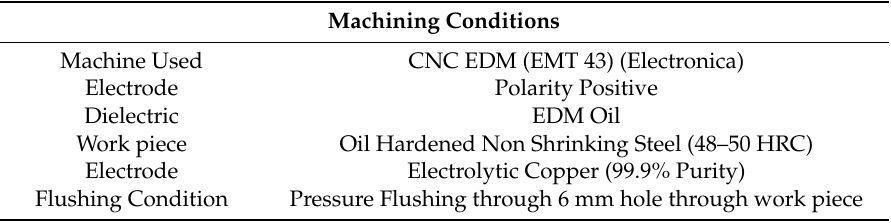
Table 4. Specification of Die-Sinking electrical discharge machining (EDM)